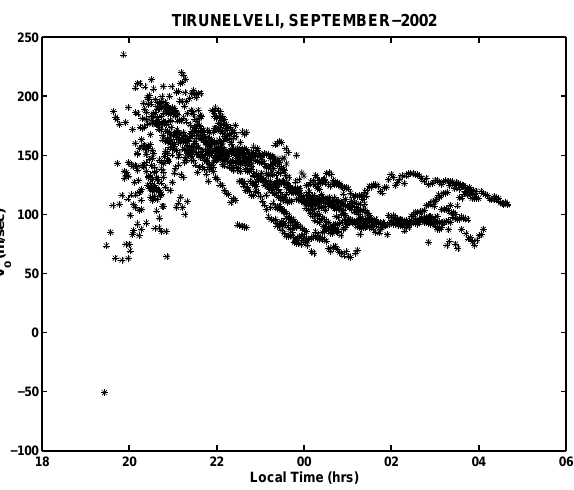
Fig. 6. Variation of coherence scale d I , for pre-midnight weak scin- tillation patterns, with monthly average 10.7-cm solar flux (in units of 10 − 22 Wm − 2 Hz − 1 ).